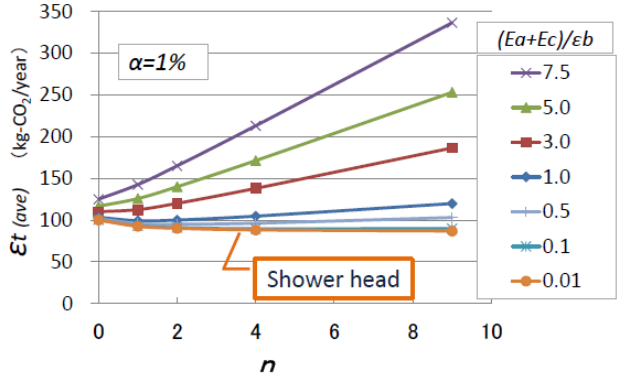
Figure 11. Environmental impacts of